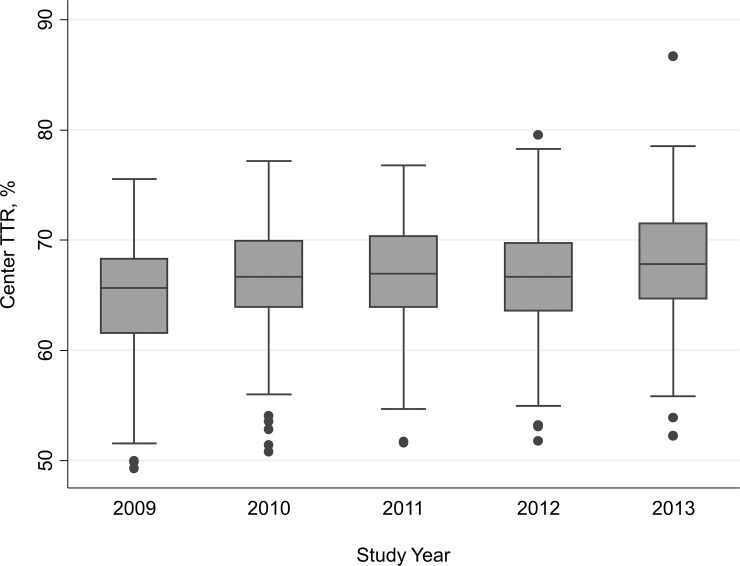
Boxplot of Center TTR by study year, showing the overall increase of anticoagulation quality over the years.